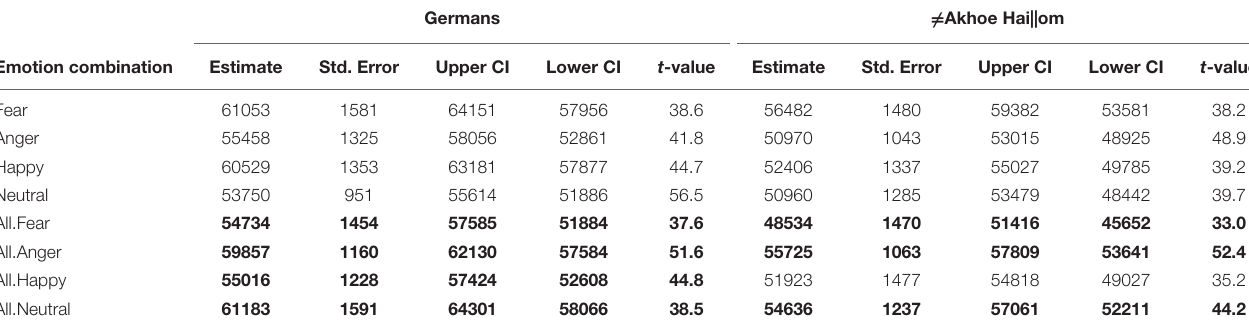
FIGURE 1 | Mean cumulative fixation duration for the comparison of the target emotion (e.g., Fear) vs. all distractors combined (e.g., All.Fear) for Germans and (cid:54)= Akhoe Hai||om. Scales show the mean fixation duration in milliseconds. Significant differences are indicated by asterisks (** p < 0.01, *** p < 0.001). TABLE 1 | Estimates for the mean cumulative fixation duration (in ms) on the target emotion vs. all distractors (see also Figure 1 ) calculated for both groups. Germans (cid:54)= Akhoe